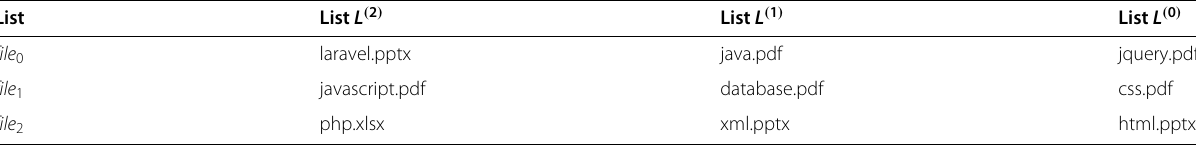
Table 7 Set of files distributed by list in the intermediate cloud environment held by the